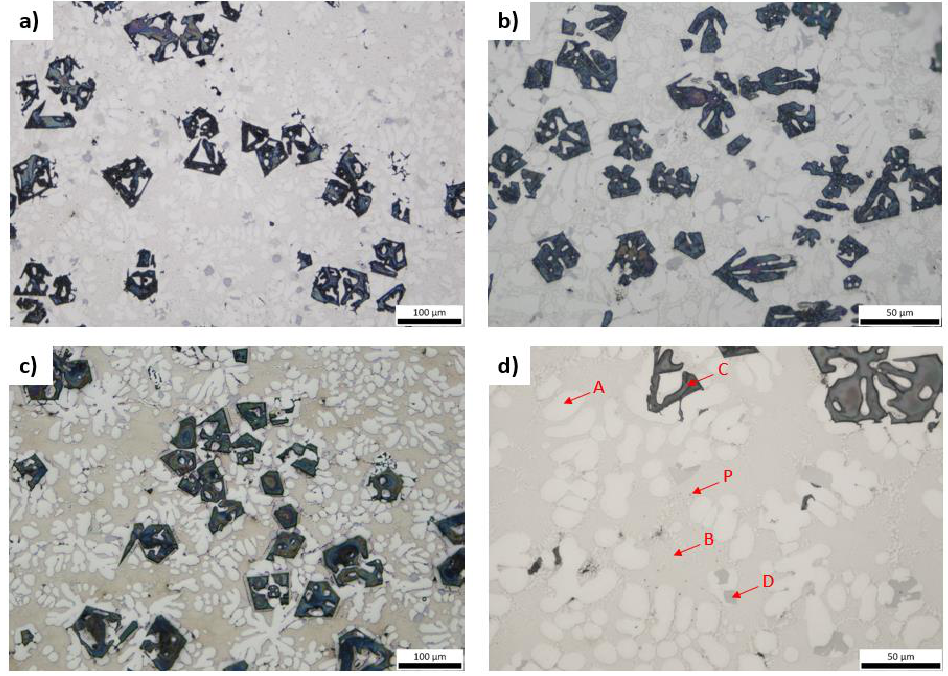
Figure 5. Optical micrographs of 1MH ( a , b ) and 1MH’ ( c , d ).